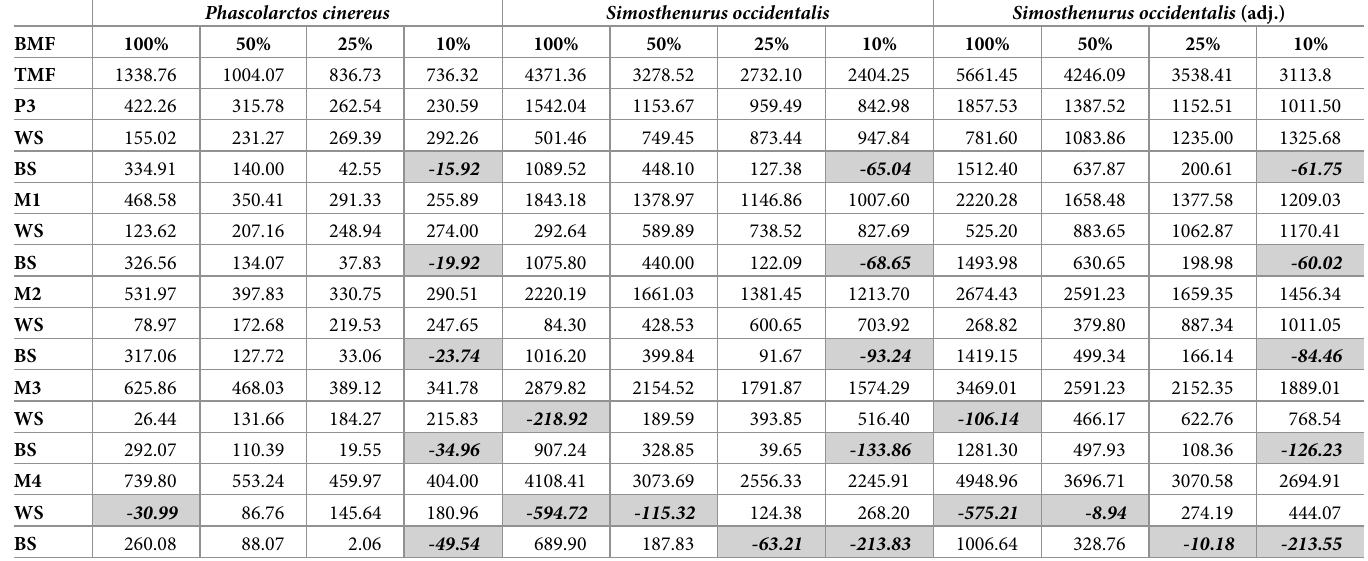
Table 2. Reaction forces at each biting tooth and TMJ during each muscle loading. BMF = balancing-side muscle force recruited, TMF = total muscle force applied, WS = working-side TMJ, BS = balancing-side TMJ. Tensile forces (-) represented by bold-italicised